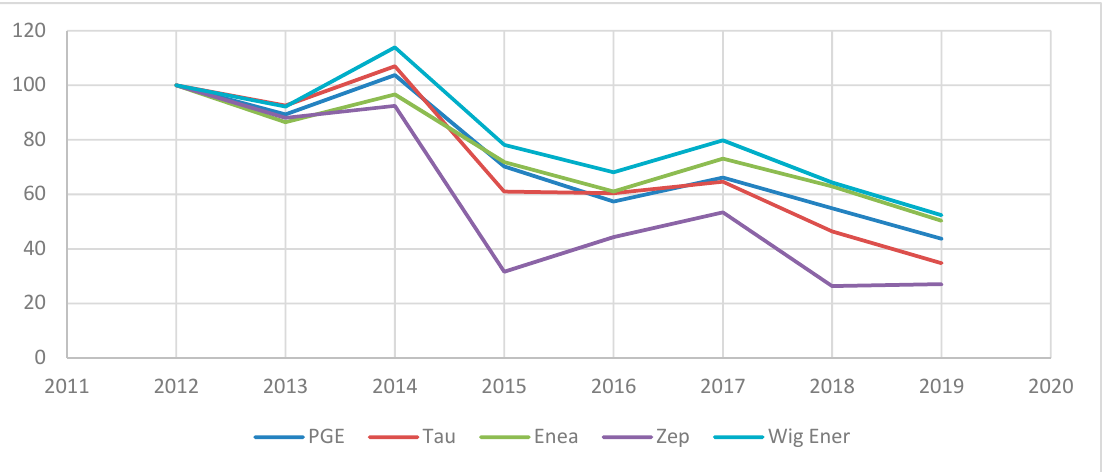
Figure 11. Ratios of changes in the level of stock market quotations of the analyzed companies in the period 2012–2019 (2012 = 100) Source: Own elaboration.